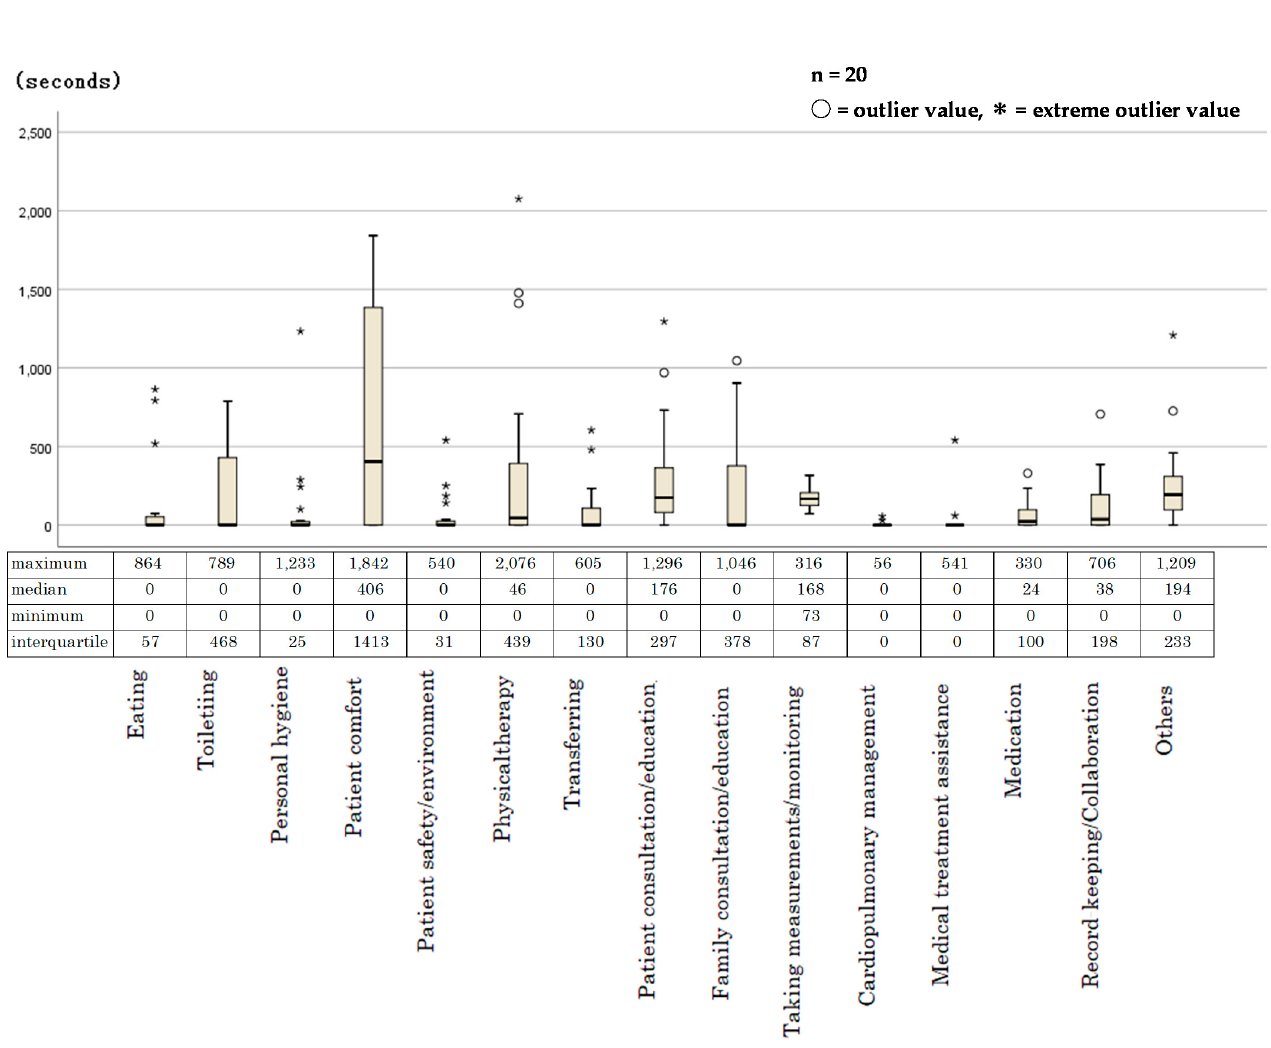
Figure 2. Box and whisker plots for each